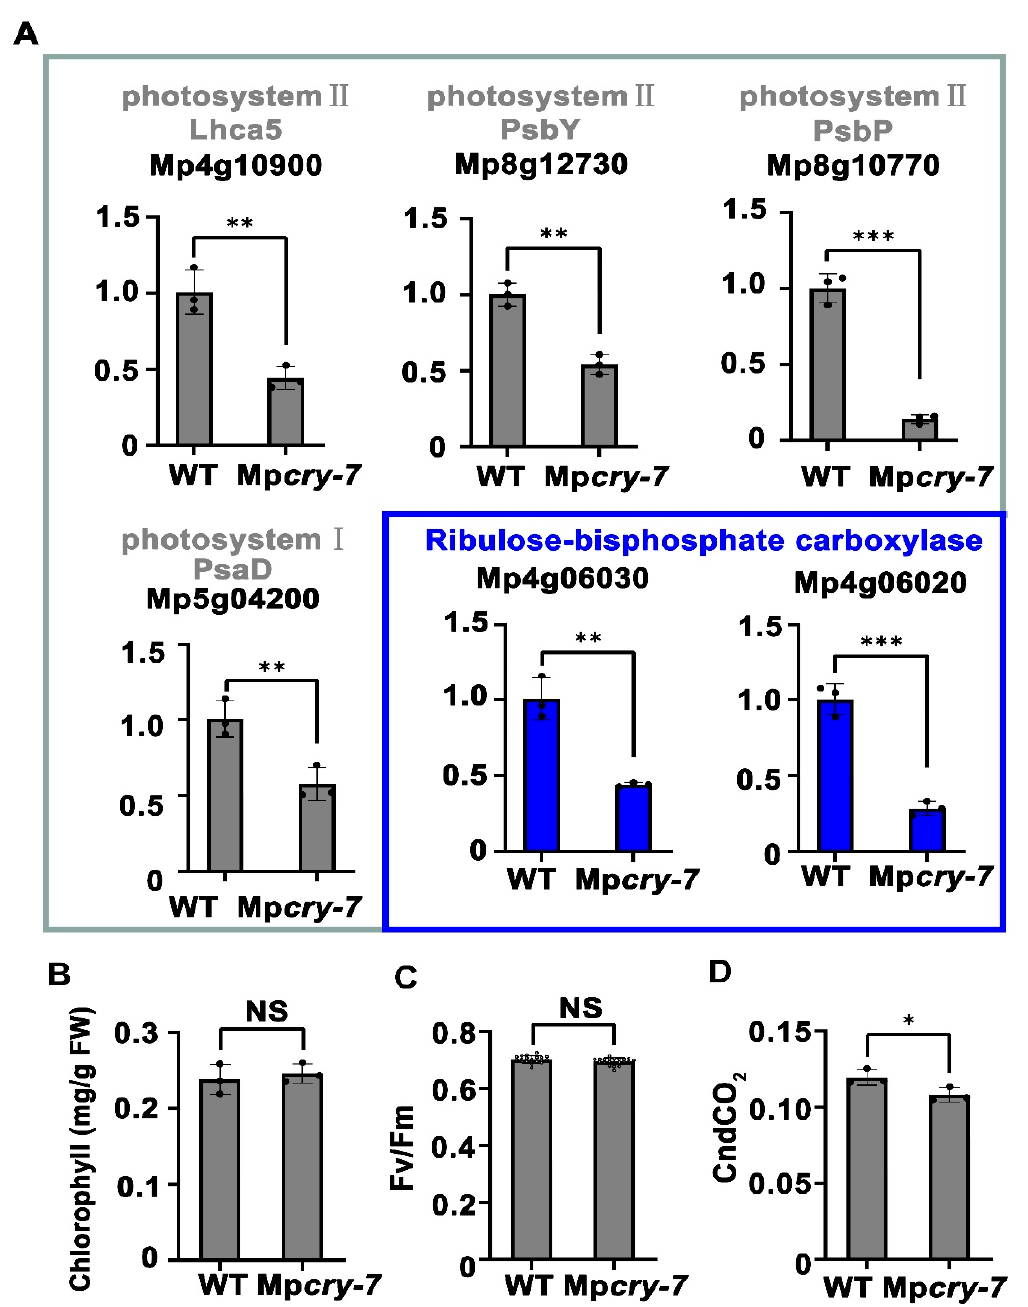
Figure 4. Mp cry regulates the transcription of photosynthesis-related genes under BL. ( A ) qPCR showing that the expression of genes coding proteins in photosystem II, photosystem I and ribulose-bisphosphate carboxylase in WT and Mp cry-7 ( n = 3 biological replicates). Student’s t test: *** p < 0.001, ** p < 0.01, * p < 0.05. ( B – D ) Chlorophyll levels (mg/g FW), Fv/Fm and total conductance to CO 2 for WT and Mp cry-7 grown under BL. NS, No significance. In ( C ), asterisk indicates p <